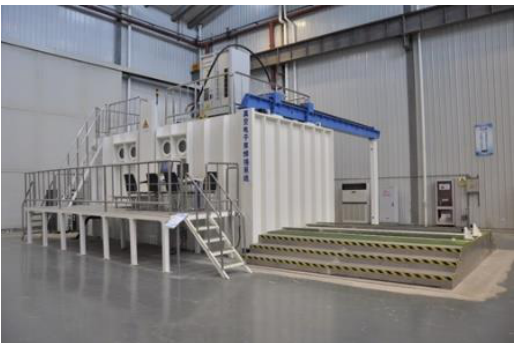
Figure 1. The structure of WCCB blanket. ( a ) WCCB blanket ( b ) internal structure of WCCB blan- ket ( c ) internal structure of FW. (Reprinted with permission from ref. [12] © (2021) Elsevier).